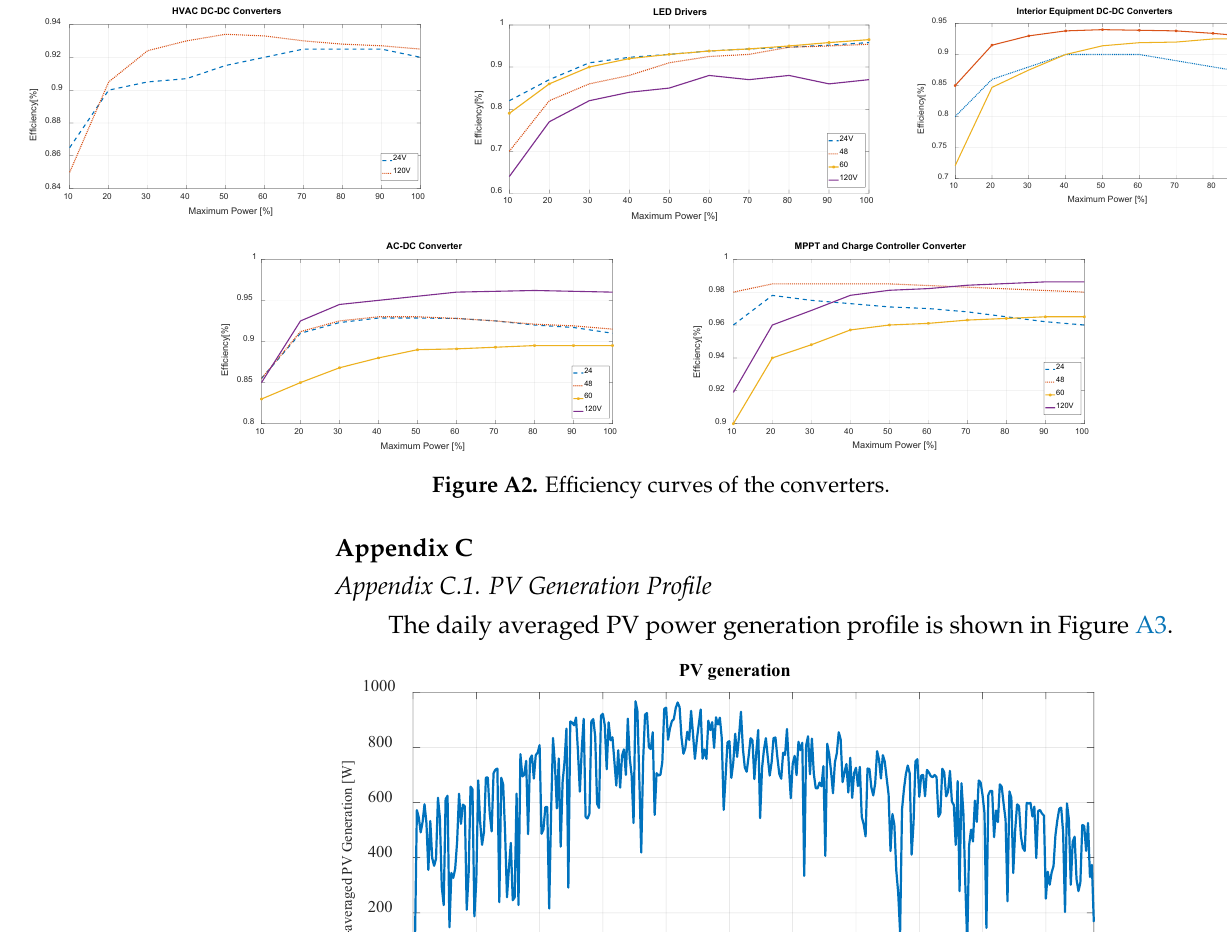
Figure A2. Efficiency curves of the converters.